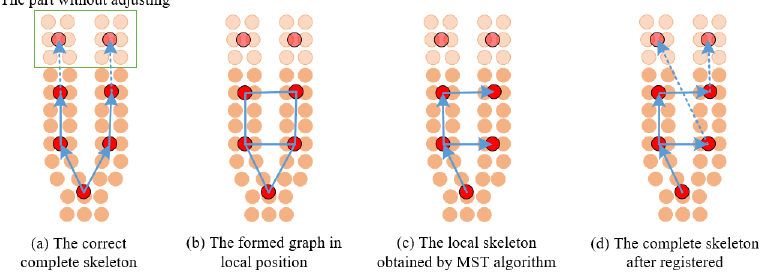
Figure 5. The problem in the skeleton produced by Xu et al.’s [15] algorithm layering by heights.